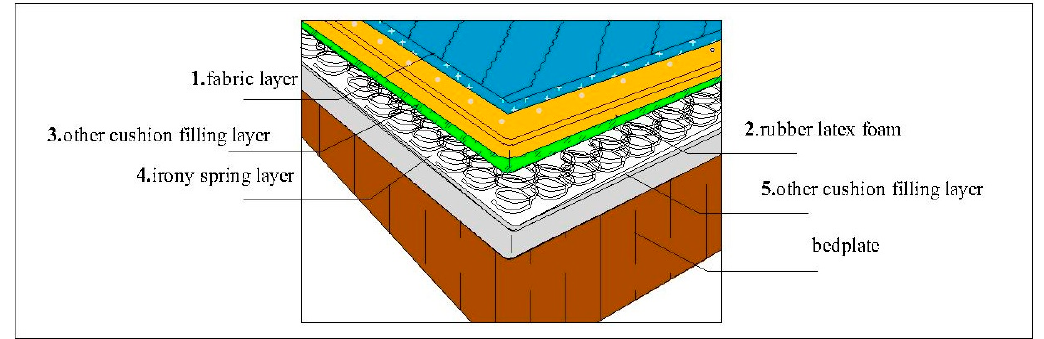
Figure 2. The layered structure of common rubber latex foam mattress.